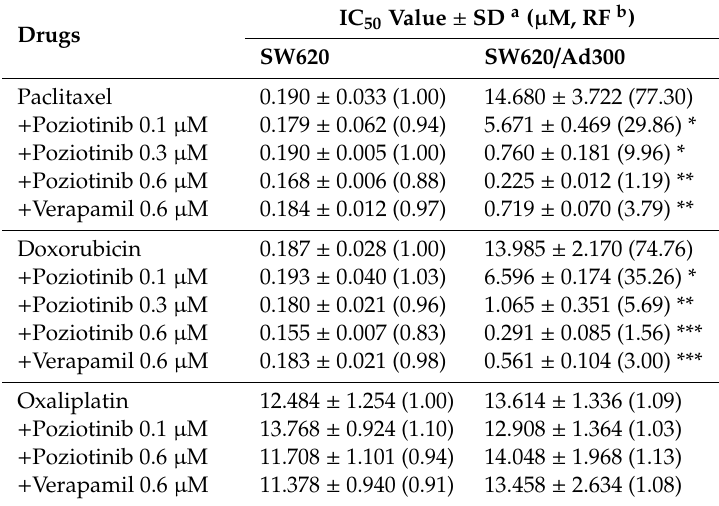
Table 2. The e ff ect of poziotinib and verapamil on the e ffi cacy of paclitaxel, doxorubicin and oxaliplatin in colon cancer cells overexpressing the ABCB1